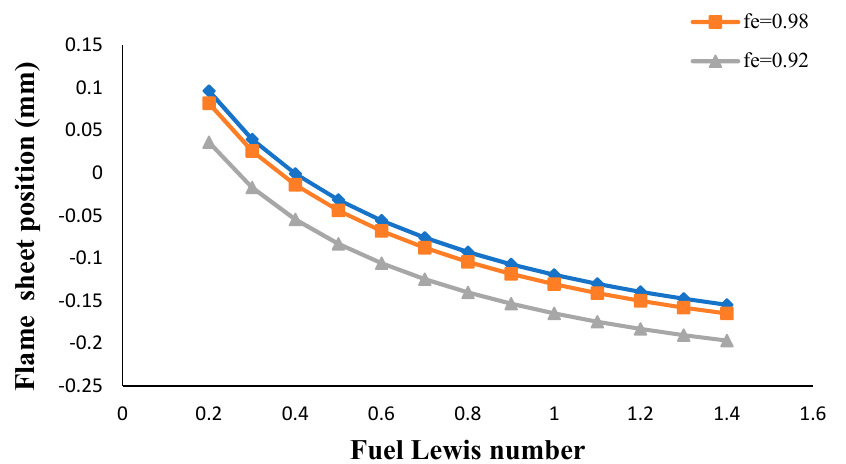
Figure 5. Flame sheet position against the fuel Lewis number for different porosity factors.